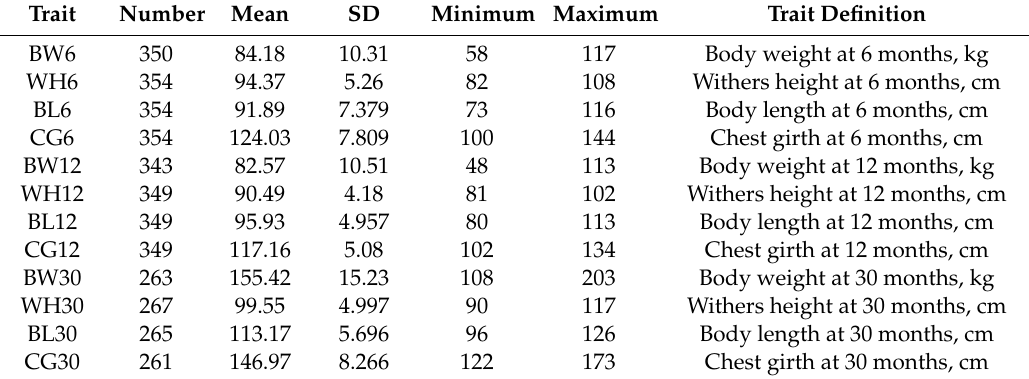
Table 1. Summary and definition of phenotypic traits, numbers of animals, mean values, standard deviations (SD), and minimum and maximum